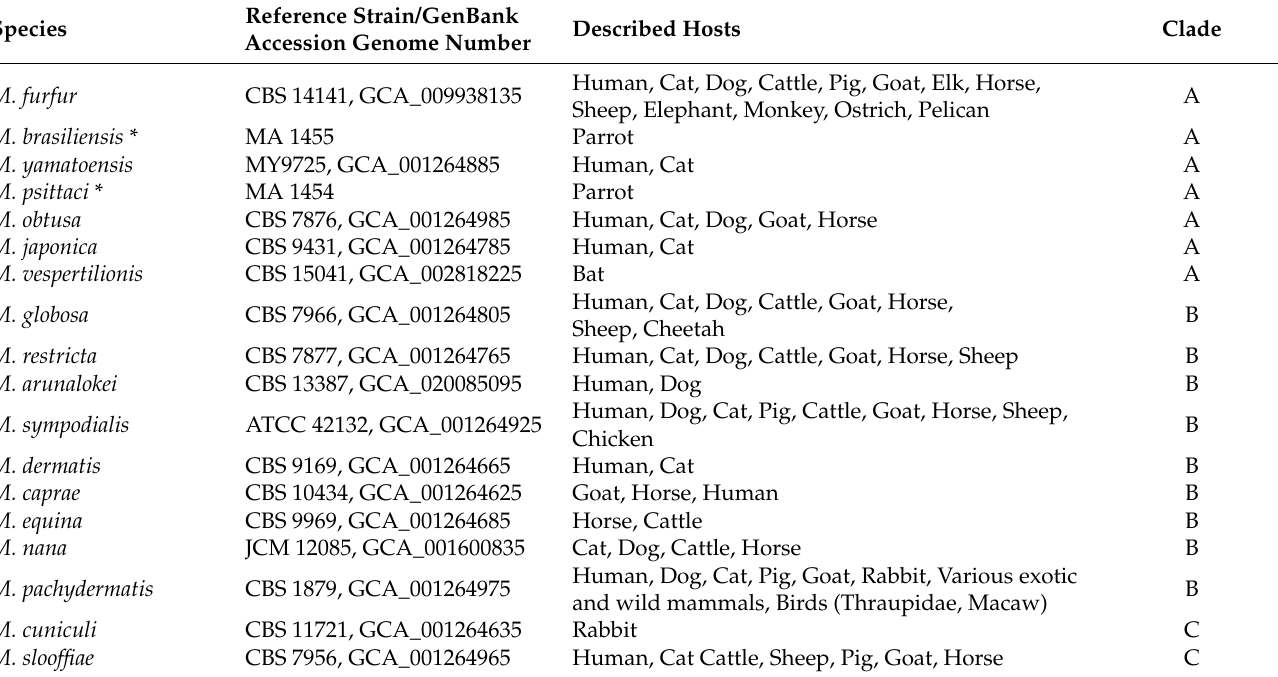
Table 1. Classification of Malassezia by species, reference strain, hosts and phylogenetic